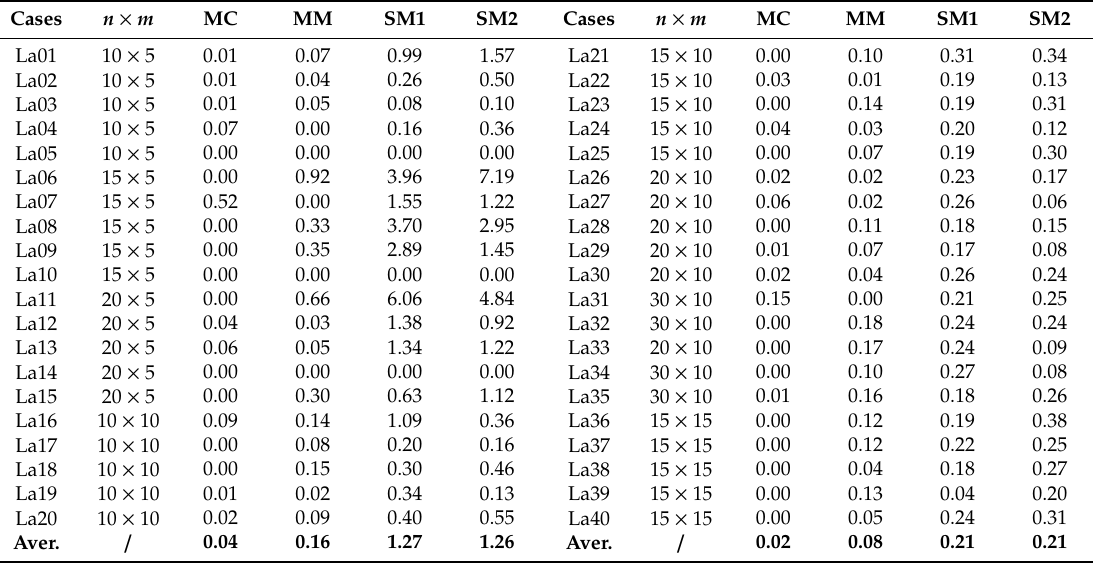
Table 3. The values of A d for the algorithms Monte Carlo approximation-based MOEA (MC), meta-model (MM), total slack time (SM1), and free slack time (SM2) in the problem set LA.